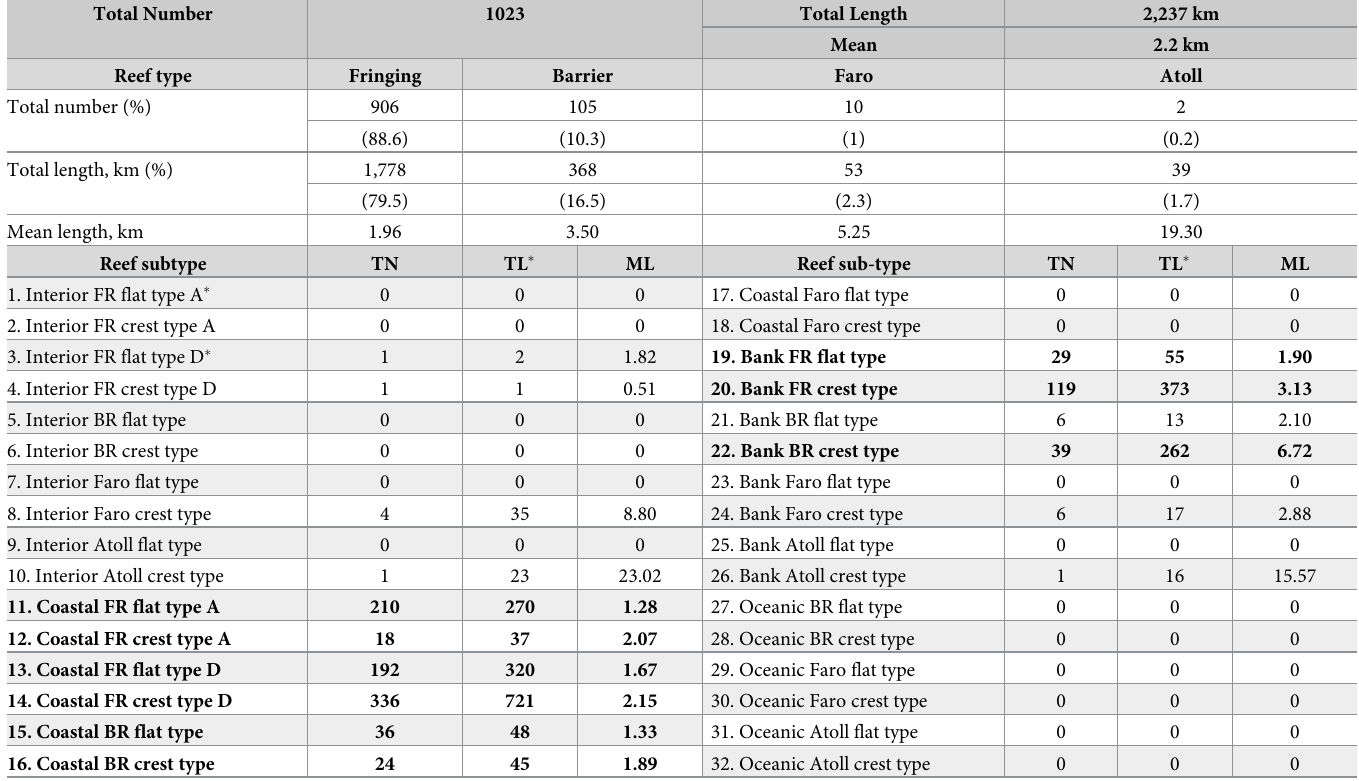
Table 1. Number and length (km) of linear breakwater reefs ( > 500 m) and their subtypes in the Greater Caribbean. Only 16 out of the possible 32 reef subtypes are present and, of those, 9 are common (bold) and 7 are uncommon (kmz data for all reefs provided in the S1 File). Total